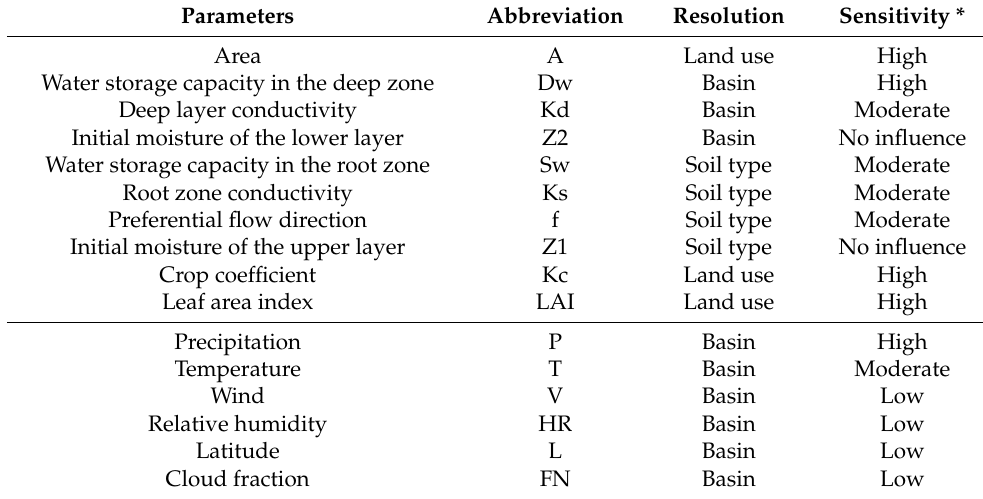
Table 2. Parameters, resolution, and sensitivity of land use and climatological variables.